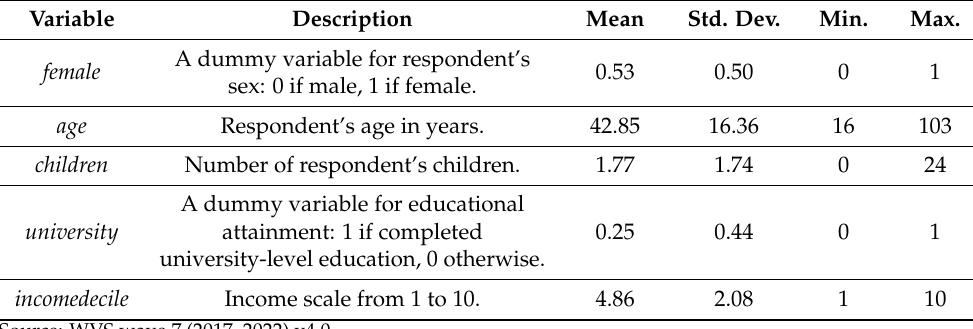
Table 1. Descriptive statistics of socio-demographic